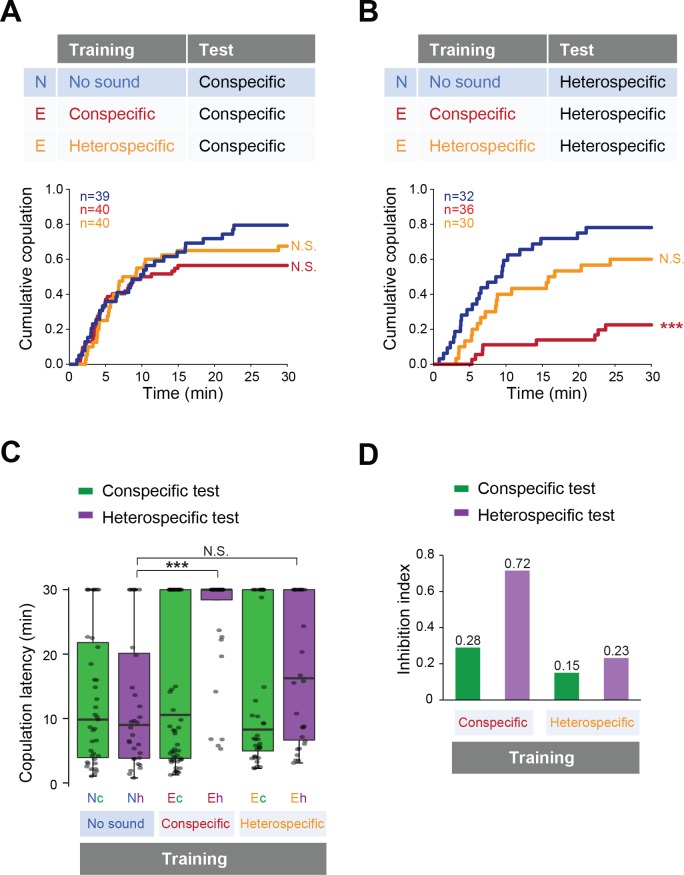
Fine-tuned song response of females after the training.(A, B) Cumulative copulation rate in the conspecific song test (A) or heterospecific song test (B) after training females. Naïve group (no sound during training) and experienced groups (trained with conspecific song or heterospecific song) are shown. The color code is the same with that in Figure 2. N, naïve; E, experienced. (C) Copulation latencies of females under playback of conspecific song (green bars) or heterospecific song (purple bars). Nc and Nh, naïve flies tested with conspecific and heterospecific songs, respectively. Ec and Eh, experienced flies tested with conspecific and heterospecific songs, respectively. (D) Inhibition index under playback of conspecific song (green bars) or heterospecific song (purple bars) after training of conspecific song or heterospecific song. Inhibition index = (copulation ratioNaïve - copulation ratioExperienced)/copulation ratioNaive. N.S., not significant, p>0.05; ***p<0.001; Log rank test versus naïve group (A, B); Kruskal–Wallis test versus naïve group (C).